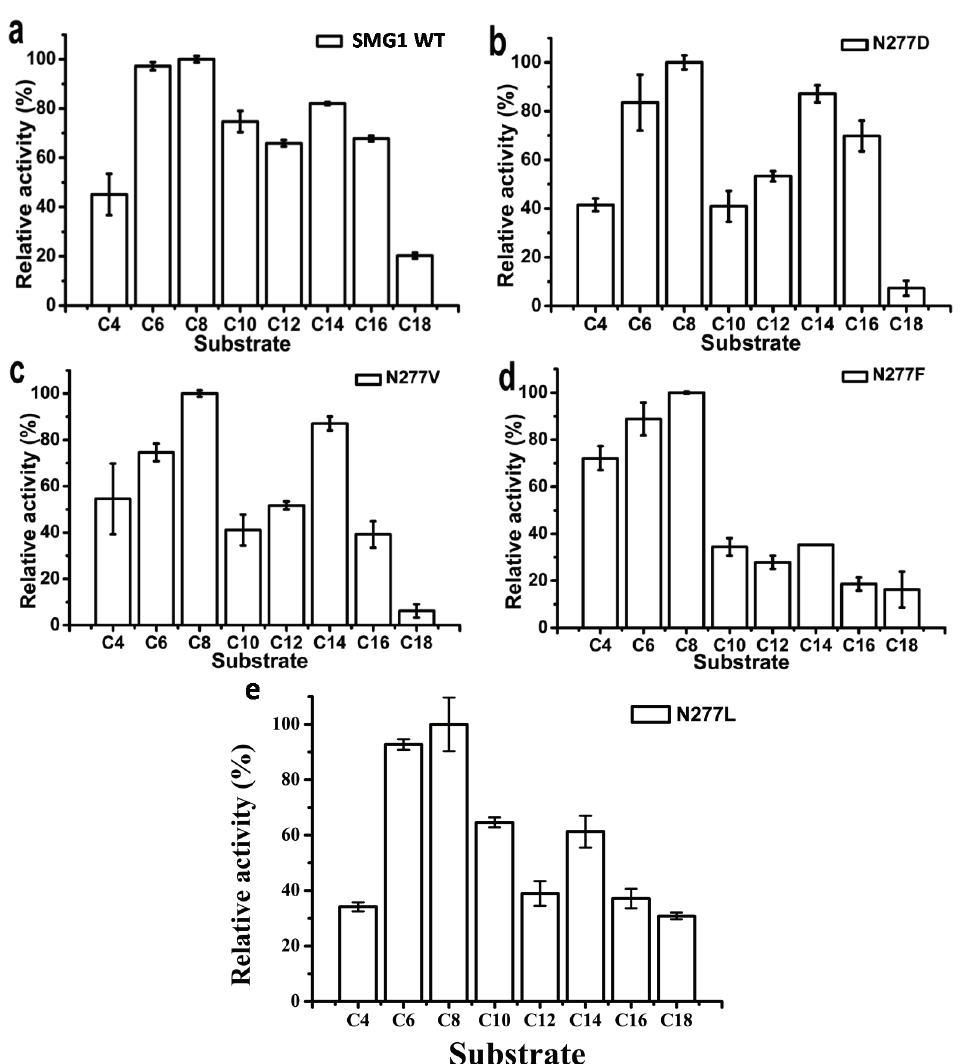
Figure 3. Substrate-specificities of SMG1 and its mutants toward various pNP esters. The relative activity is expressed by using the highest activity of each sample as 100%, and all other values have been standardized to this reference value. ( a ) SMG1 WT; ( b ) N277D; ( c ) N277V; ( d ) N277F; ( e )